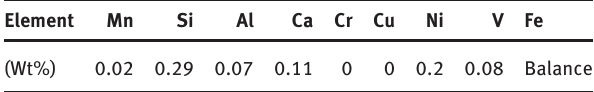
Table 1: Chemical composition of iron powder.